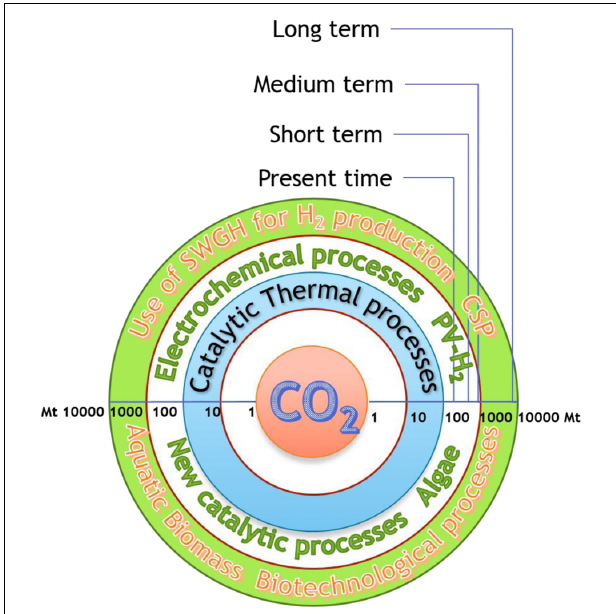
FIGURE 5 | Stepwise implementation of strategic technologies for CO 2 conversion, innovative processes and amount of CO 2 converted into added value products, fuels and